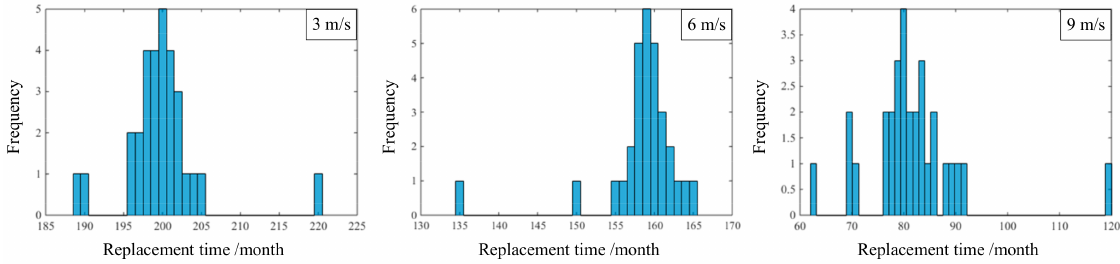
Figure 5. The histogram of replacement